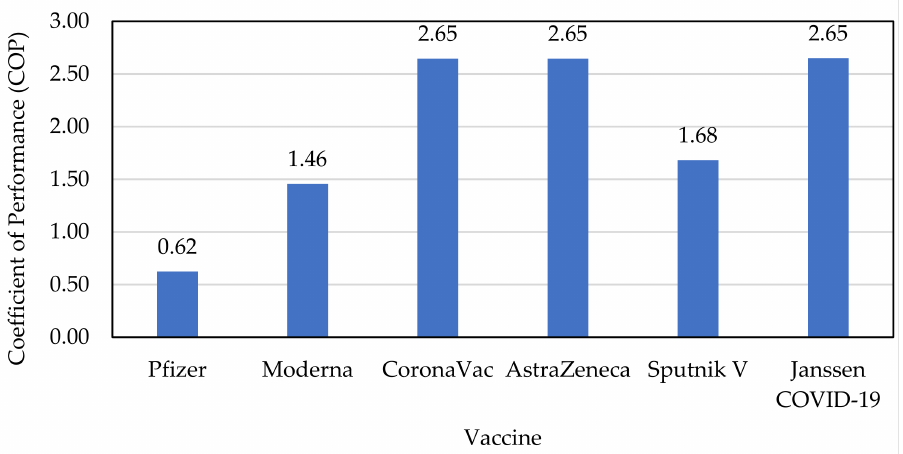
Figure 2. COP of refrigeration system with condenser fans and evaporator for